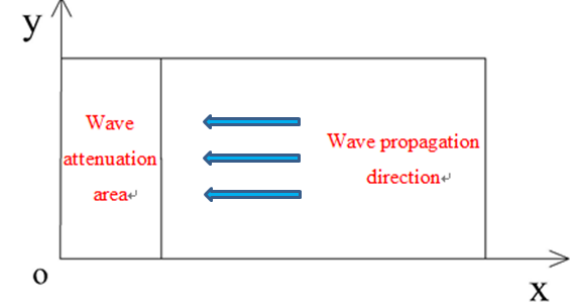
Figure 4. Wave elimination region.